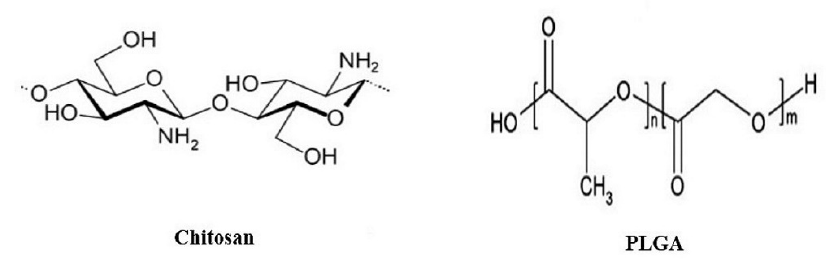
Figure 3. Chemical structures of the most used polymers in engineering polymer-based nanoparticles for MAFLD therapy.